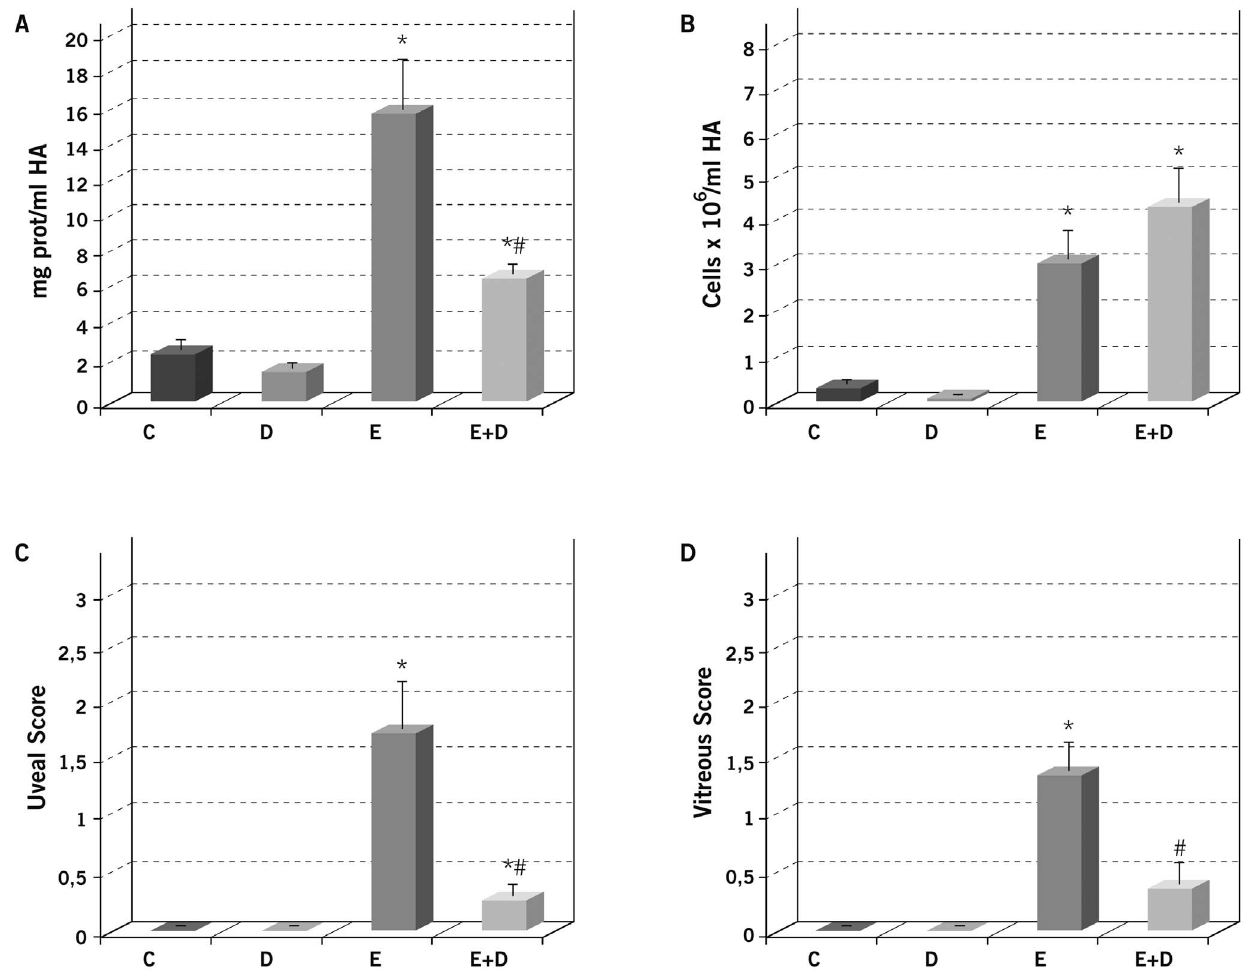
Figure 1. Effect of Daclizumab on protein concentration (A) and cellular infiltration (B) in the aqueous humor collected 24 h after endotoxin treatment, and on the histopathological score of uveal (C) and vitreous (D) cellular infiltration. Each value represents the mean 6 SE. * p # 0.05 vs . the Control and Daclizumab groups and # p # 0.05 vs. the Endotoxin group.